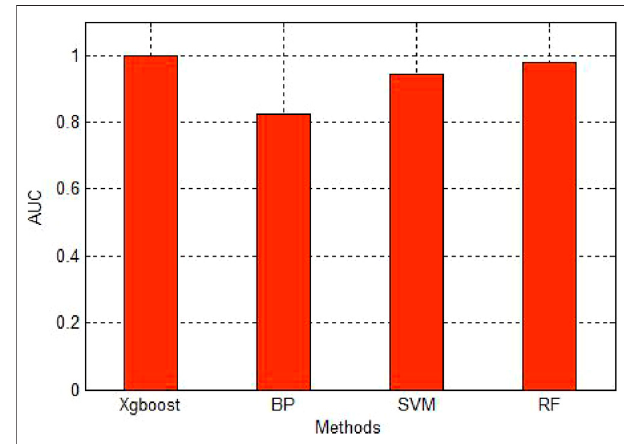
FIGURE 4 | AUC of four